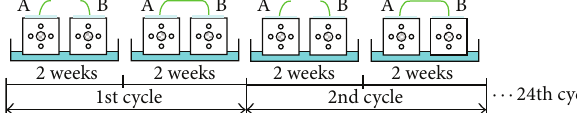
Figure 2: Experimental process of this